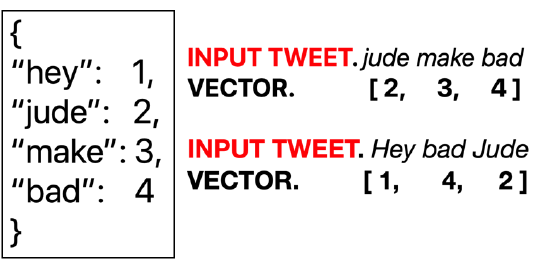
Figure 1. Vectorization of tweet data: Each token is assigned an ID, and each tweet is converted into a vector of token